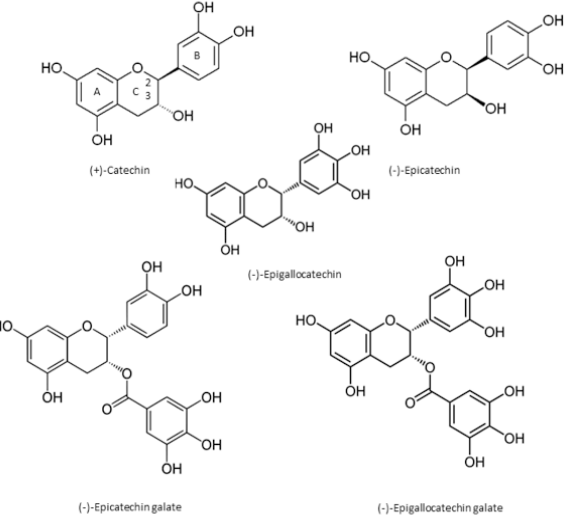
Figure 2. The structural formulae of catechins found in green tea leaves (Source: [67]).